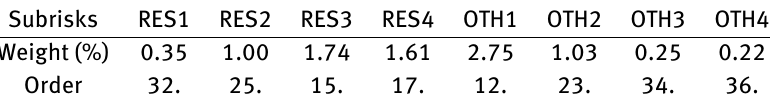
Table 6: Resulting values of subrisks weights – Part IV.